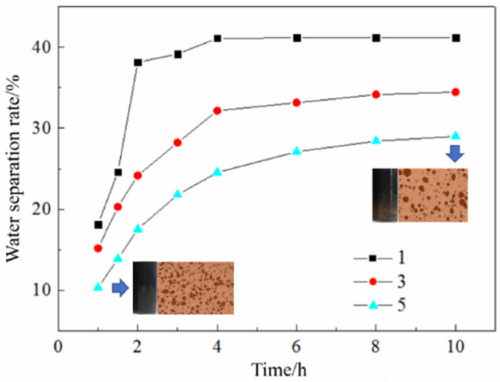
Figure 4. Relationship between the emulsion water separation rate and the sieve plate number.